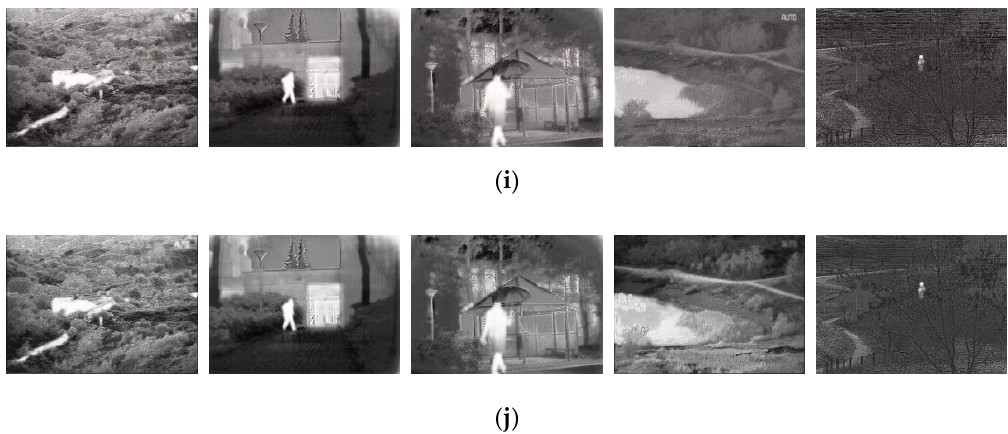
Figure 8. Qualitative fusion results on five typical infrared and visible image pairs from the TNO database. From left to right: Bunker, Kaptein_1123, Kaptein_1654, Lake, and Sandpath. From top to bottom: ( a ) the visible image, ( b ) the infrared image, ( c ) deep fuse [36], ( d ) curvelet transform (CVT) [89], ( e ) dual-tree complex wavelet transform (DTCWT) [118], ( f ) GFF [26], ( g ) gradient transfer fusion (GTF) [101], ( h ) fusion GAN [33], ( i ) FLGC-fusion GAN [48], ( j ) DDcGAN) [49].